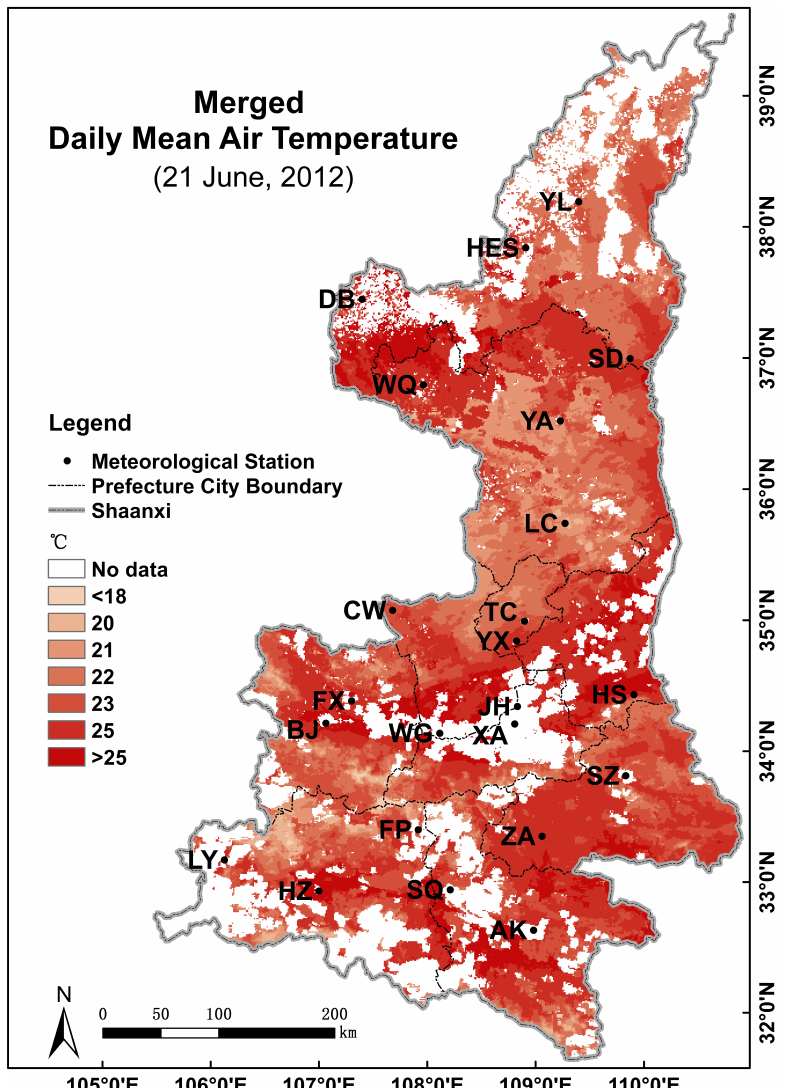
Figure 7. Merged image using the daily mean air temperatures ( TAs ) estimated using the daytime and nighttime land surface temperatures (LSTs) from the TERRA and AQUA MODIS products for 21 June